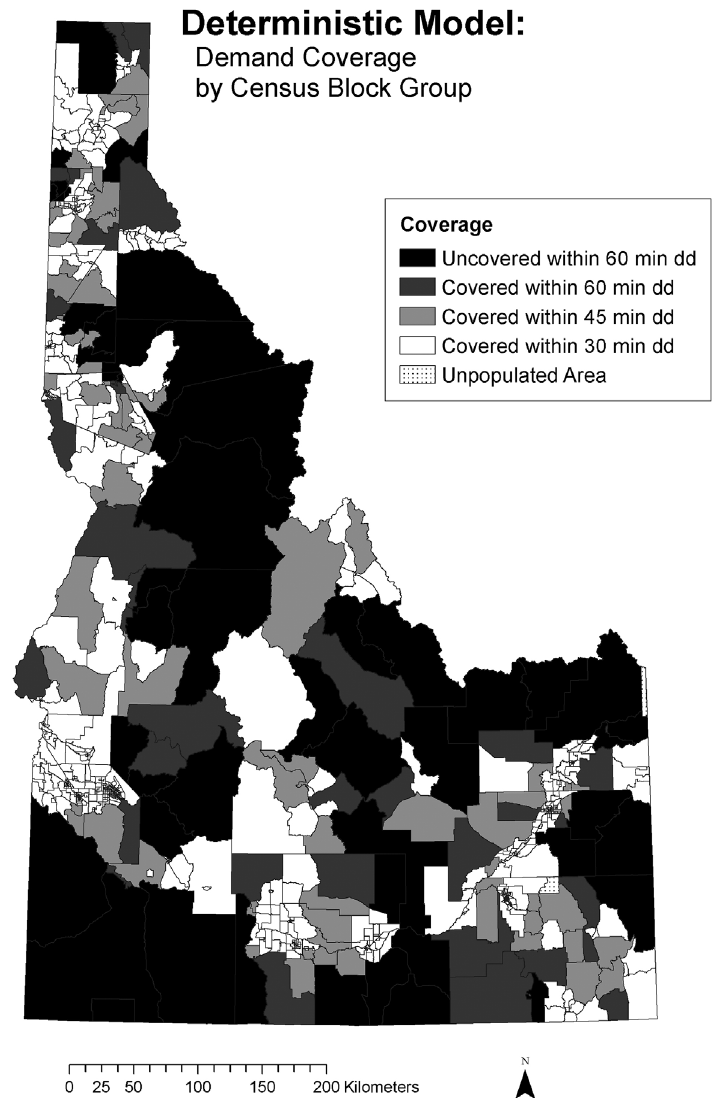
Fig. 5. Block group model